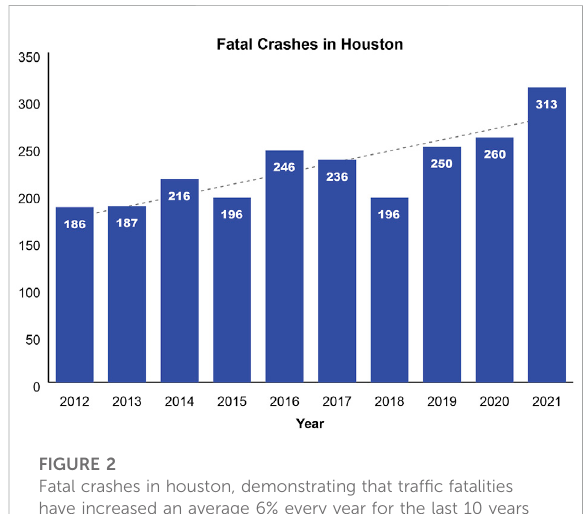
FIGURE 2 Fatal crashes in houston, demonstrating that traf fi c fatalities have increased an average 6% every year for the last 10 years (Texas Department of Transportation,